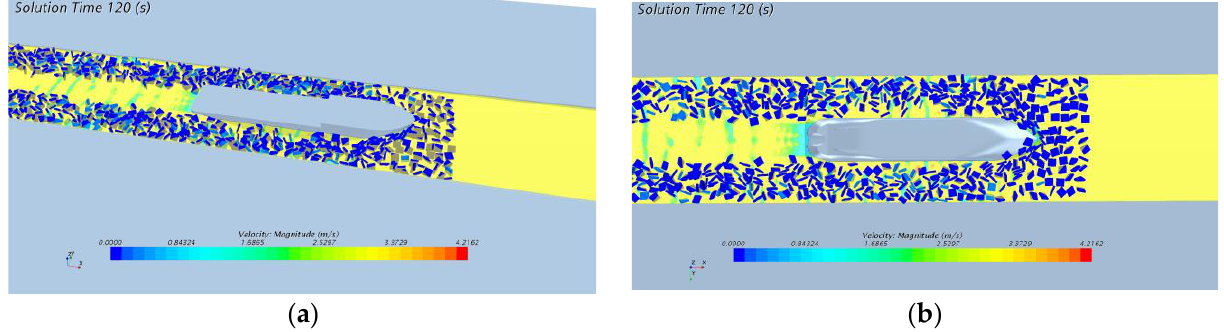
Figure 7. The snapshot at 120 s of the simulation when the air-bubble system has not been activated: ( a ) isometric view; ( b ) bottom view.